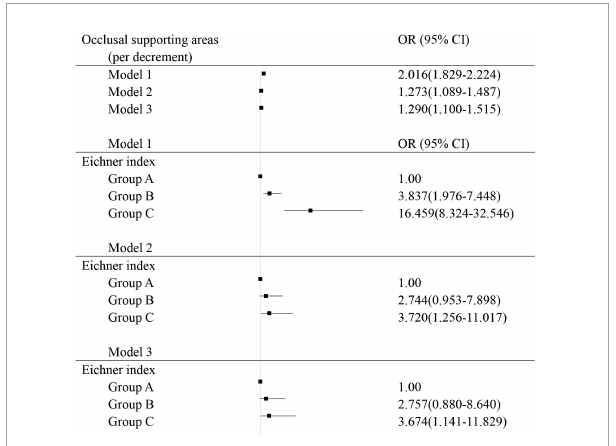
FIGURE1 Logistic regression analysis for risk factors associated with cognitive impairment; Group A: 4 functional occlusal areas; Group B: 1–3 functional occlusal areas or 0 area with anterior occlusal contact; Group C: with no functional occlusal contact; Model 1: univariate; Model 2: adjusted for sex and age; Model 3: adjusted for age, sex, body mass index, education levels, smoking and alcohol drinking, diabetes, and cardiovascular disease.